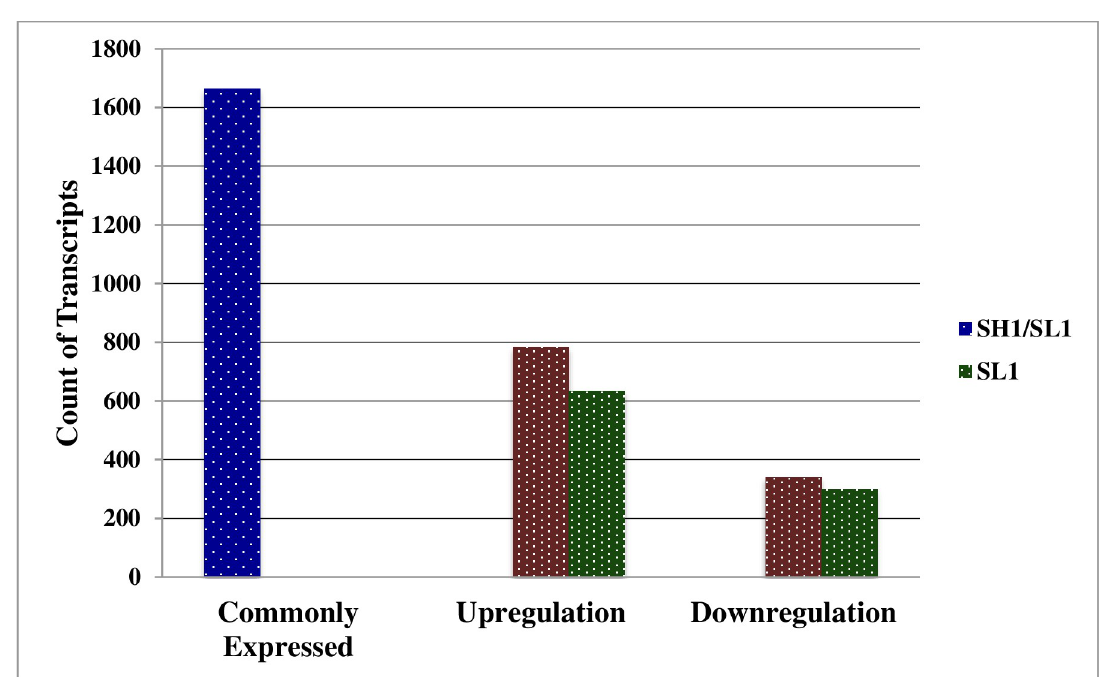
Fig 3. Identification of differentially expressed genes (DEGs) between Sa SHc and Sa SLc. Green Bar indicates commonly expressed DEGs. Blue and red bars represent upregulated and downregulated DEGs (significant at P-value threshold of 0.05).